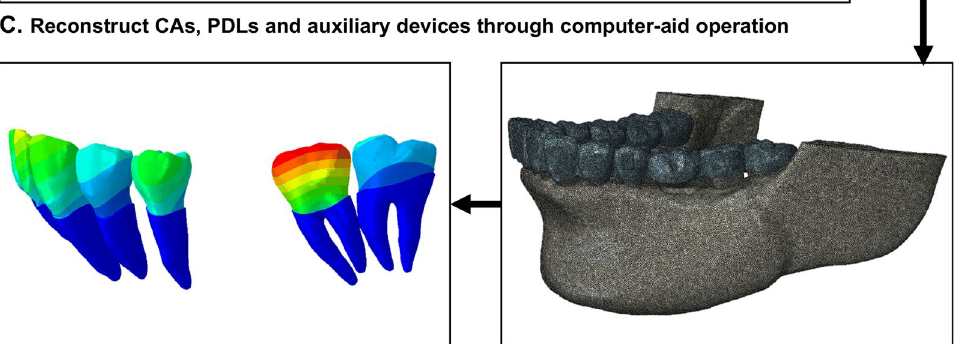
Fig. 1 The workflow of reconstructing the FE